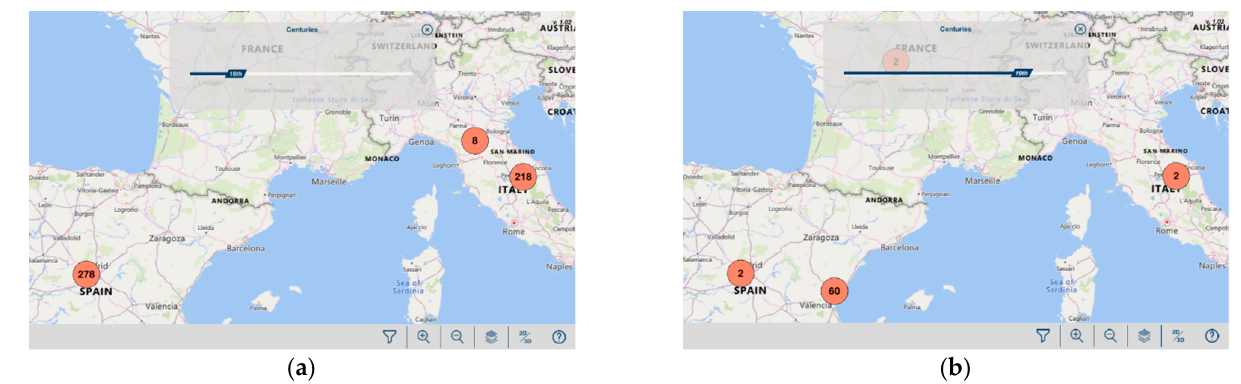
Figure 3. Timeline visualization in STMaps showing data from two centuries: 16th ( a ) and 19th ( b ).